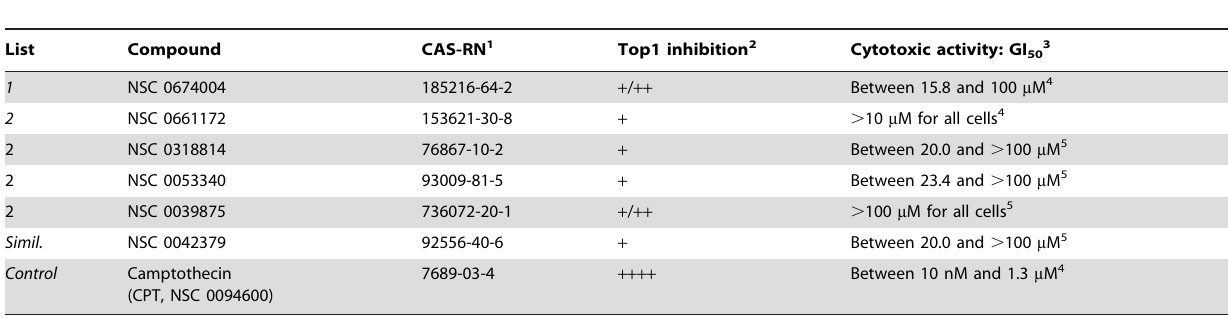
Table 3. Results of Top1 DNA cleavage assay and cytotoxicity